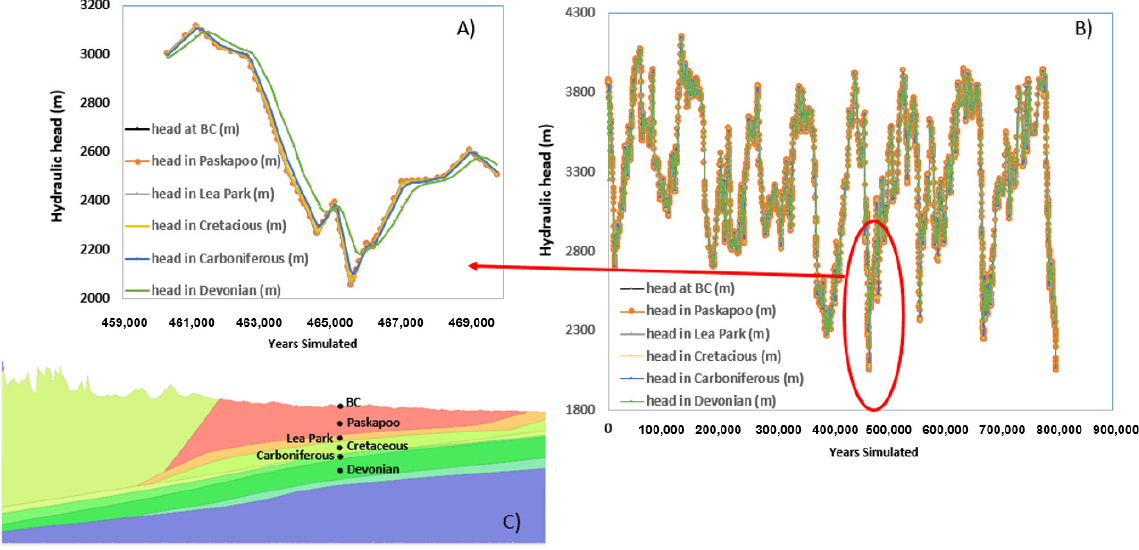
Figure 13. Simulation results for transient flow. ( A ) is the zoomed in version of the circled area in ( B ). The different lines in ( A ) and ( B ) represent the different hydraulic head (m) observation points in each formation seen in ( C ). Here BC represents the boundary condition and the other points are in the center of the named formation.